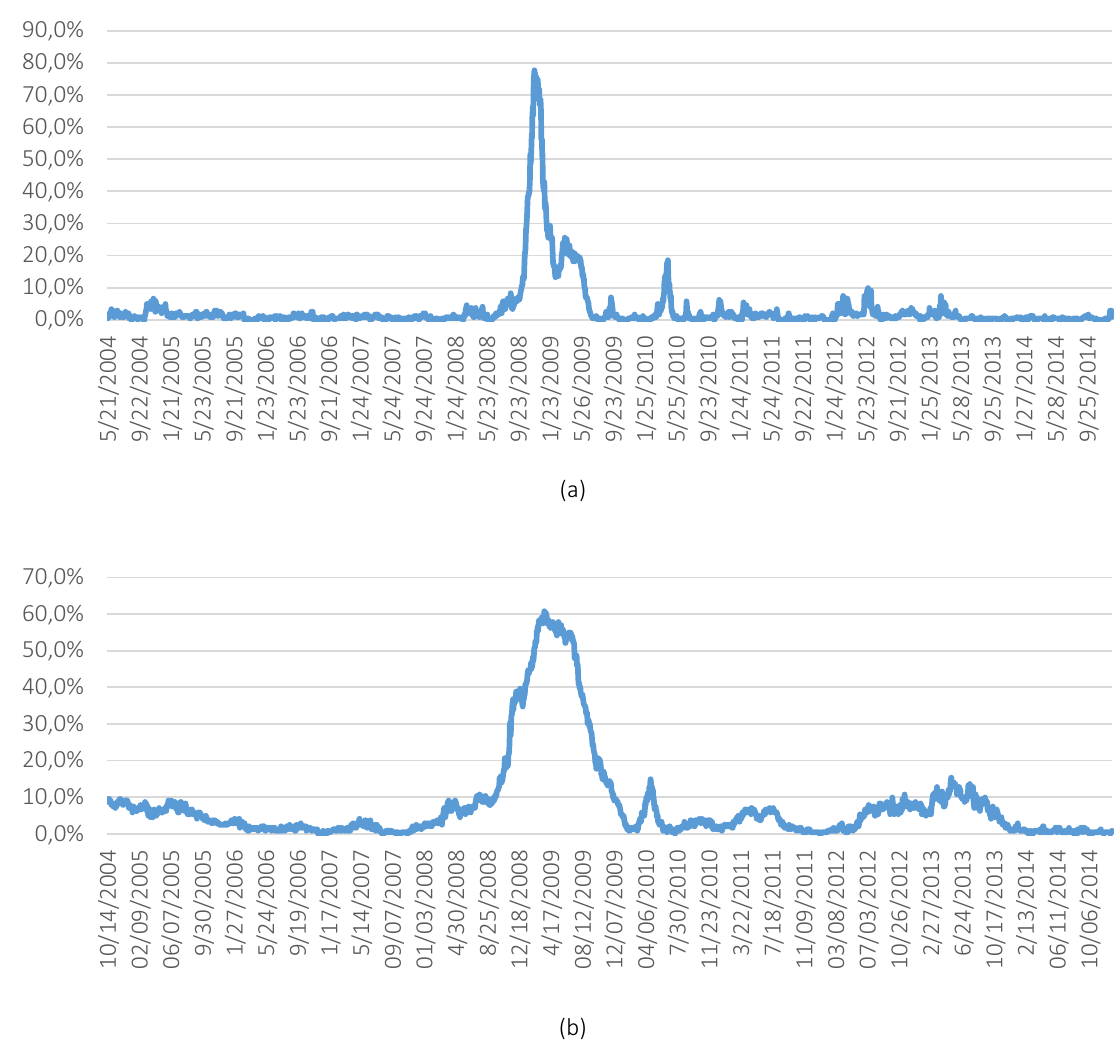
Figure 3. Fifty (50) and two-hundred (200) observation